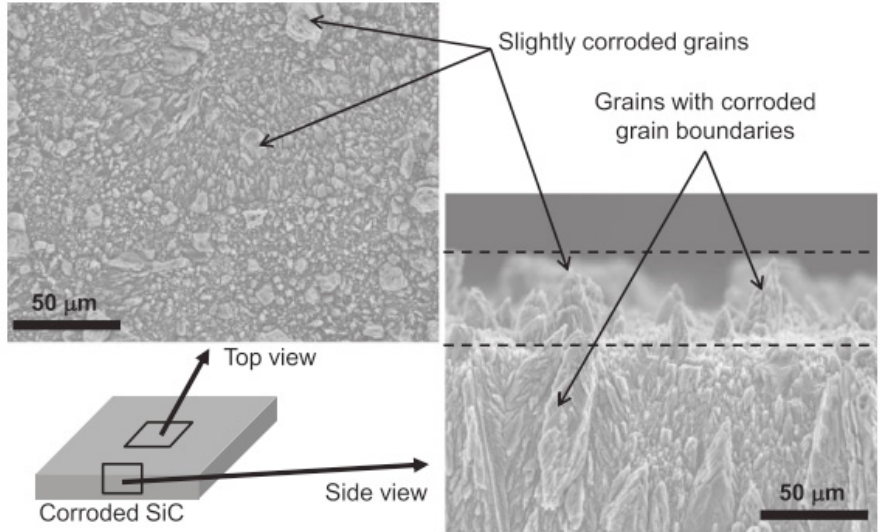
Figure 33. Scanning electron micrographs of the surface morphology of the CVD Si corroded in the 360 °C static water autoclave for 90 days. Reprinted with permission from Reference [100]. Copyright 2013 Elsevier.